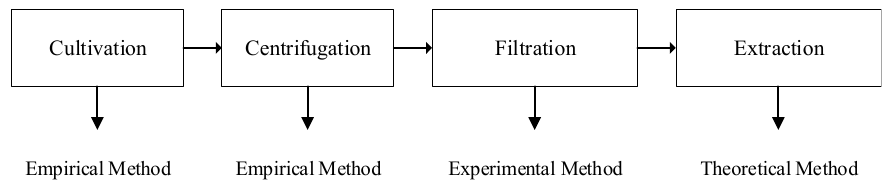
Figure 1. Research analytical process for four stages of microalgae production at Minamisoma.